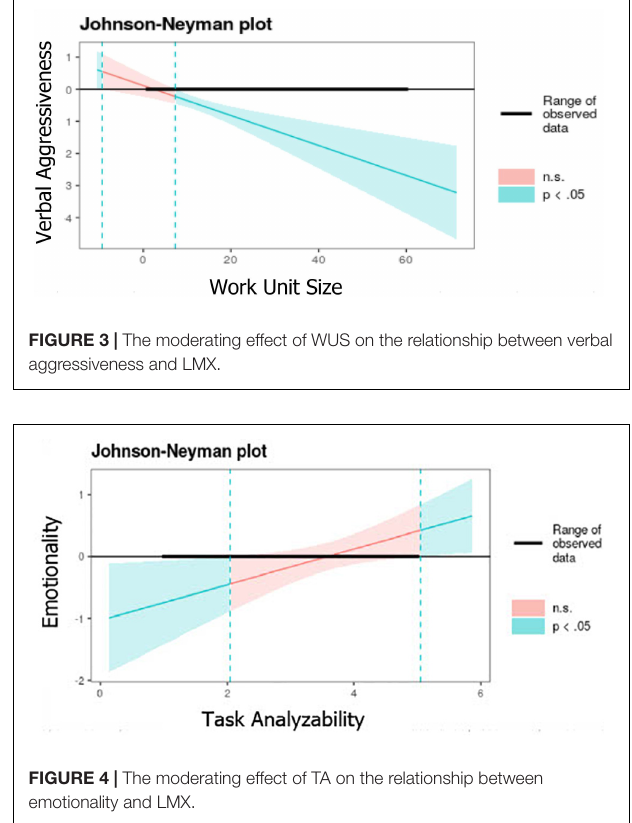
(WUS) and task analyzability (TA) on the relationship between leader’s communication style and LMX (Model 2, Table 3